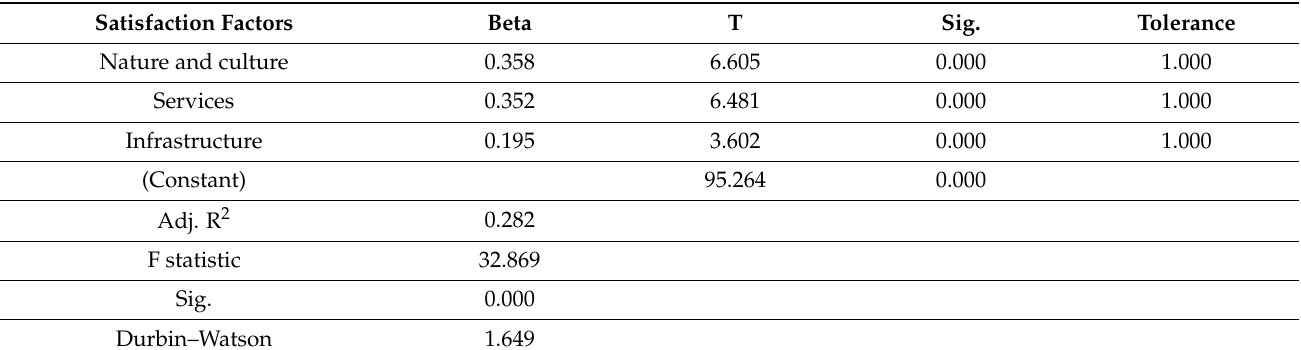
Table 4. Relationship of satisfaction factors and saying positive things about the